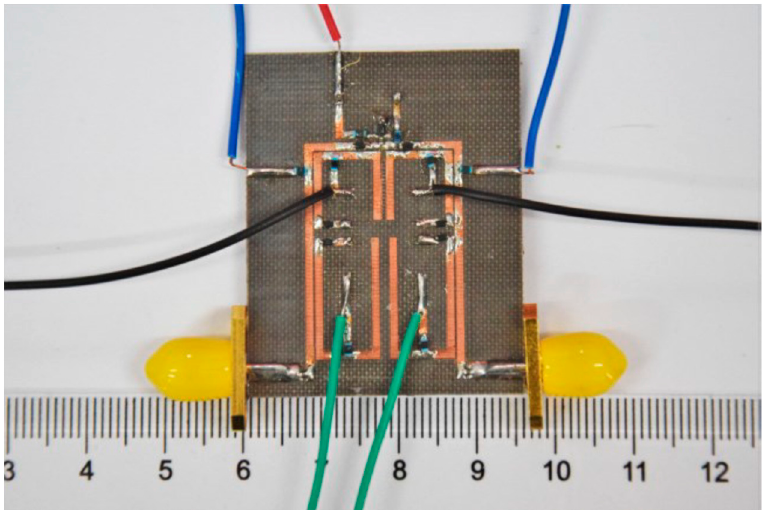
Figure 16. The tuneable filter [69].